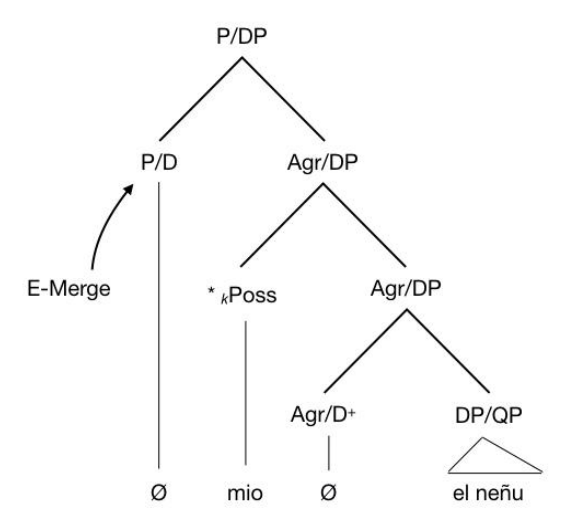
Figure 7. Postnominal possessive constructions (Type II: e.g. el neñu mio ; and Type IV: e.g. el neñu de mio ). Intermediate